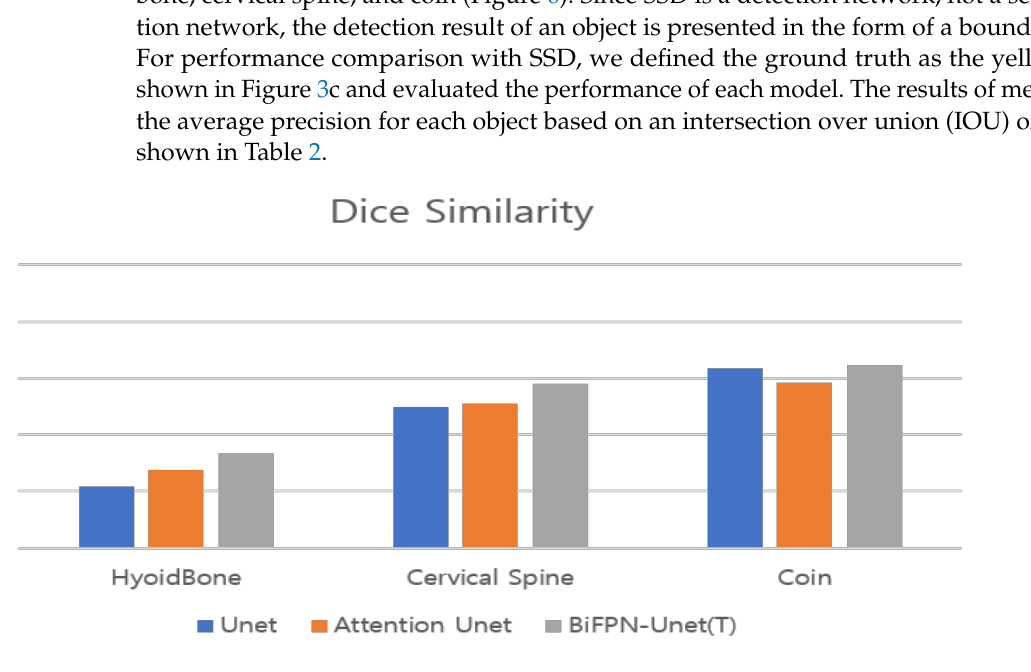
Figure 6. Performance of the proposed model in terms of Dice similarity per pixel. Table 2. Bounding box detection performance comparison among models (IOU =